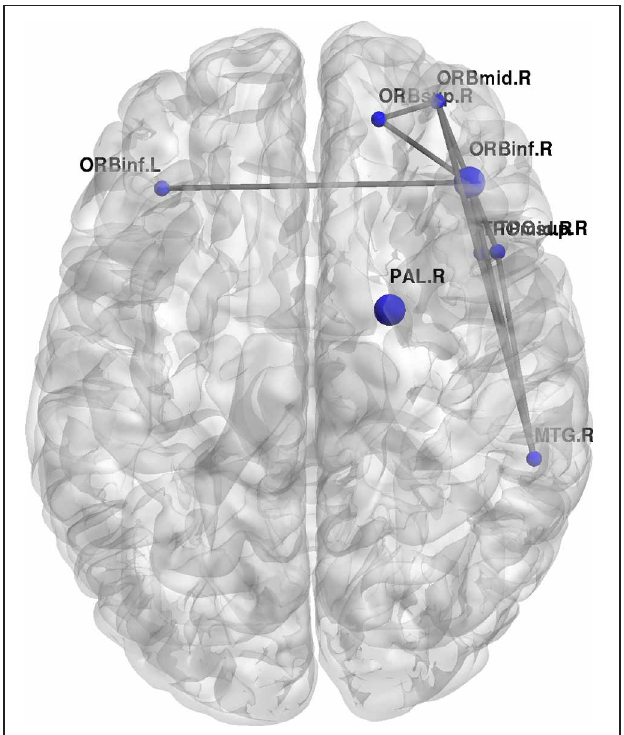
FIGURE 9 | Change in regional local efficiency following the visuo-motor adaptation learning task. The format is the same as in Figure 7 .